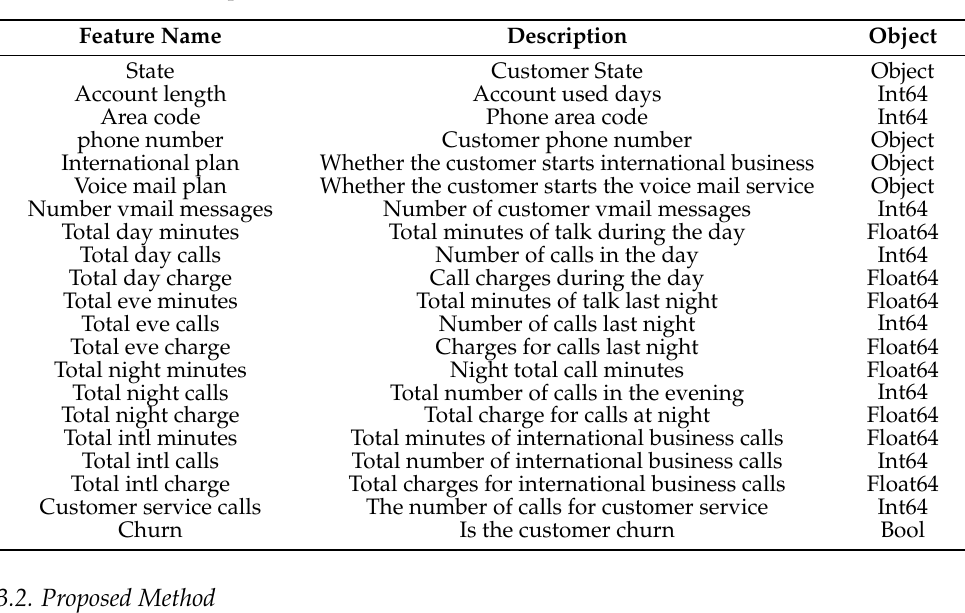
Table 1. Data-set description.